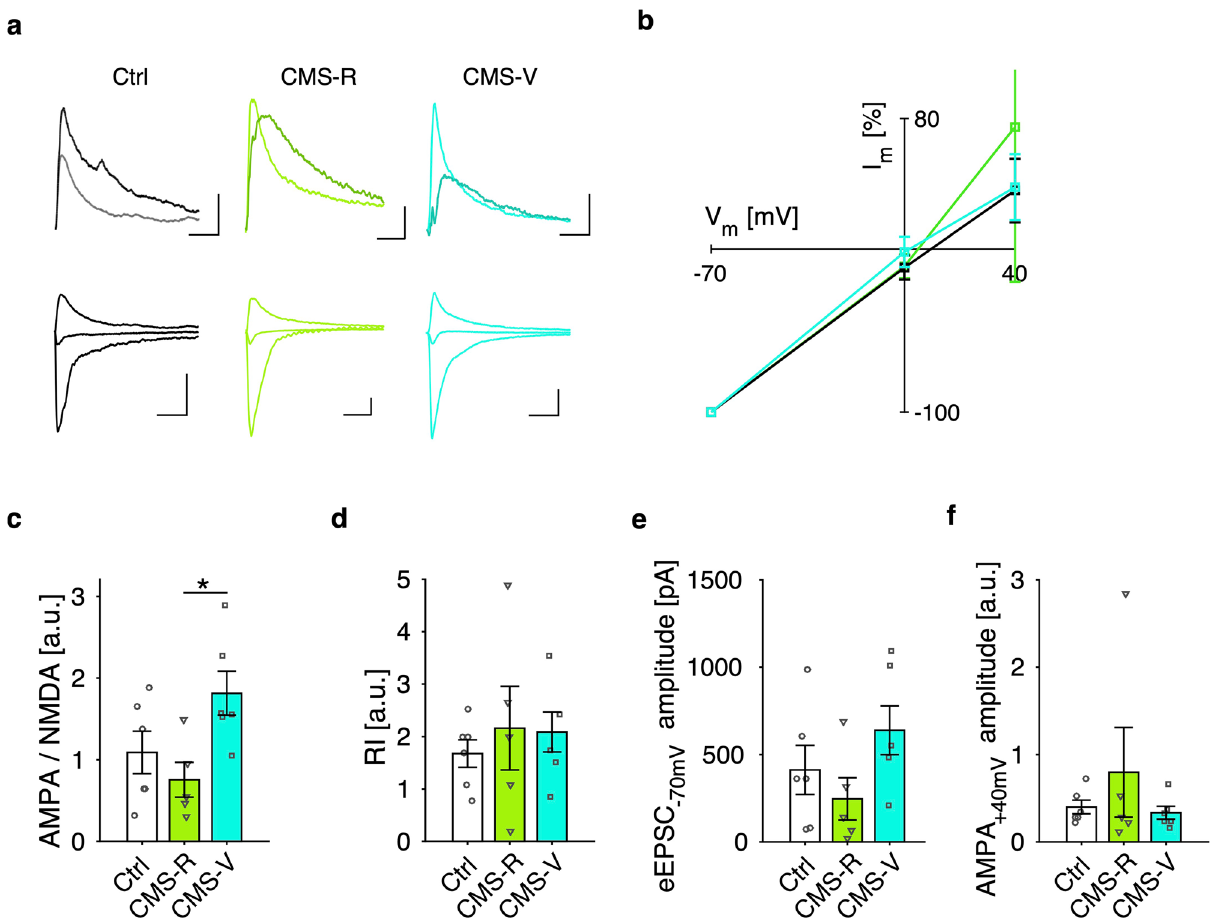
Figure 4. Vulnerability to CMS reflects higher potentiation level at layer V principal neurons. ( a ) Exemplary recordings of evoked EPSCs at layer V PNs for control (black), CMS-R (green) and CMS-V (cyan) rats: NMDA (darker color) and AMPA (lighter color) components a +40 mV holding potential (top traces) (scale bars: 100 ms × 25 pA); AMPA component at −70 mV, 0 mV and +40 mV (bottom traces) (scale bars: 100 ms × 50 pA). ( b ) AMPA I–V relationship (normalized). ( c ) AMPA/NMDA ratio is higher for CMS-V rats compared to CMS-R rats (n: Ctrl/CMS-R/CMS-V = 6/5/6 cells from 3/3/4 rats; K–W test, p = 0.036; permutation tests, B–H correction: CMS-V vs. CMS-R, p = 0.036), reflecting a higher potentiation level of synapses onto layer V PNs. ( d – f) Rectification index ( d ), absolute EPSC amplitude (at − 70 mV holding potential) ( e ) and normalized AMPA component at +40 mV ( f ) do not vary across groups (same recordings as in h; K–W test, n.s.; permutation tests, B–H correction: